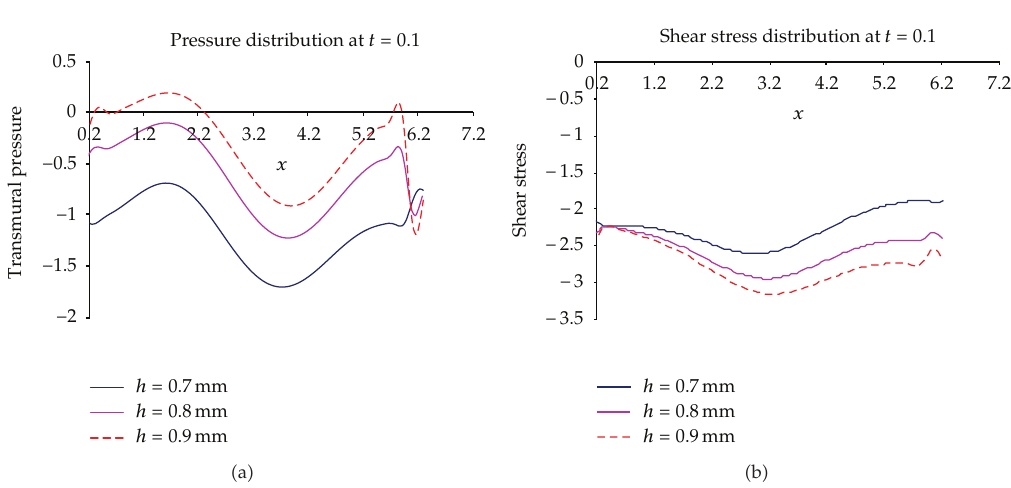
Figure 9: Transmural pressure distribution (cid:3) a (cid:4) and wall shear stress distribution (cid:3) b (cid:4) for wall thickness varying from 0.7mm to